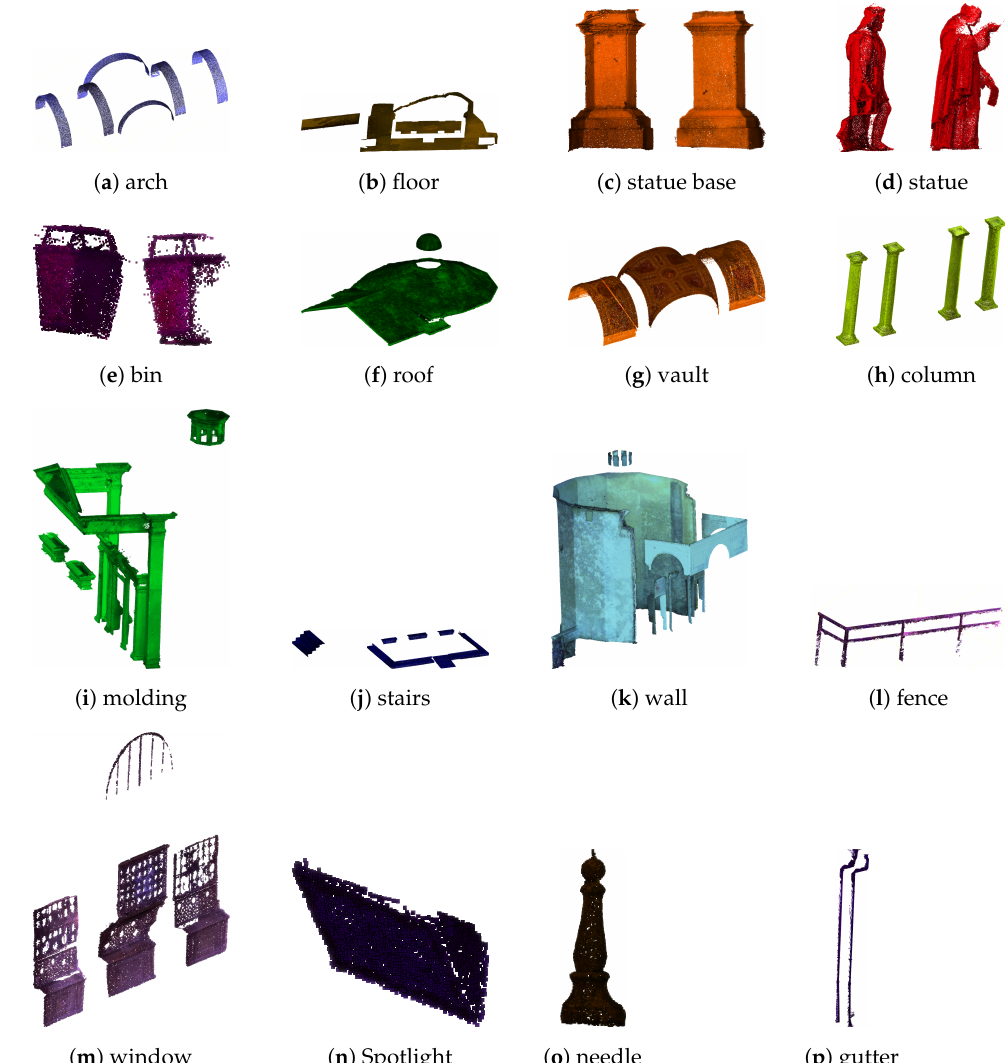
Figure 18. Isolated view of object recognized in the first chapel of Sacro